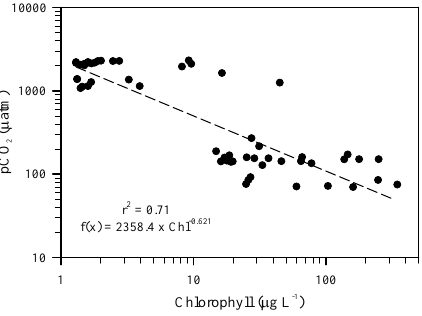
Figure 7. Relationship between the spatial p CO 2 and Chl data in the Funil Reservoir. The regression is represented by a dashed line ( r 2 = 0.71, p